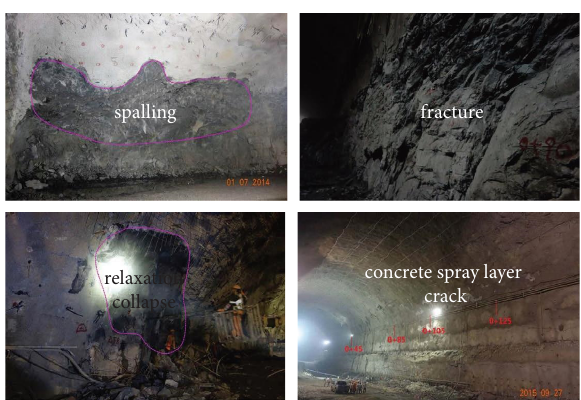
Figure 2: Stress-based failure features of the right bank powerhouse.